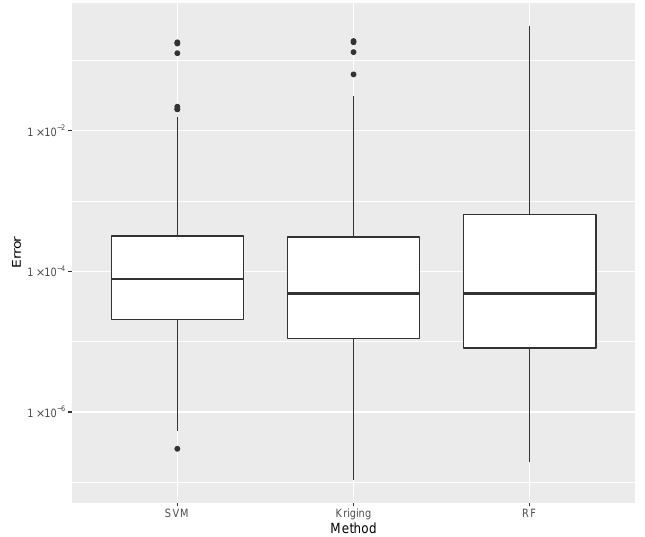
Figure 14. Comparison of b I error dispersion considering the best SVM, Kriging, and Random Forest